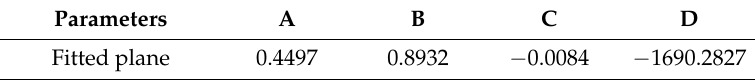
Table 5. The parameters of fitted datum plane.